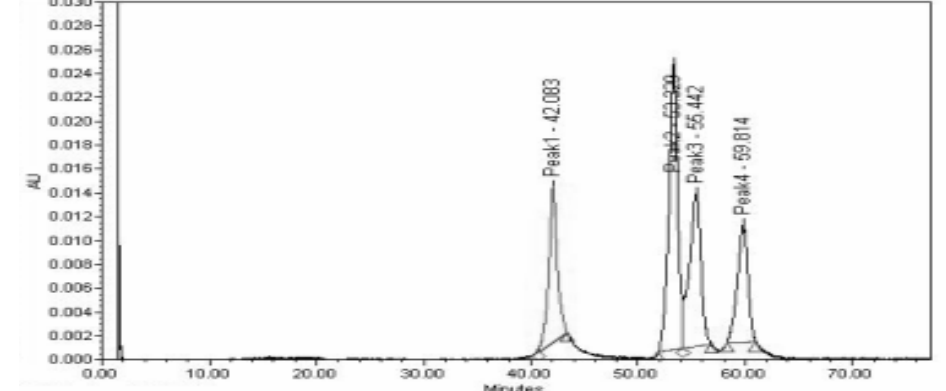
Figure 2. Figure 2. Mixture of five standards at 340 nm.